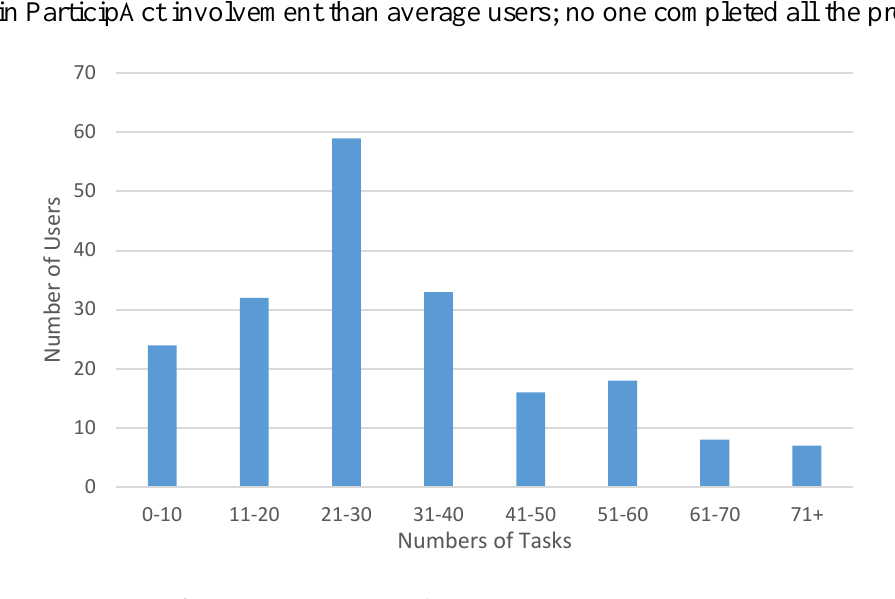
Figure 12. Number of tasks completed by